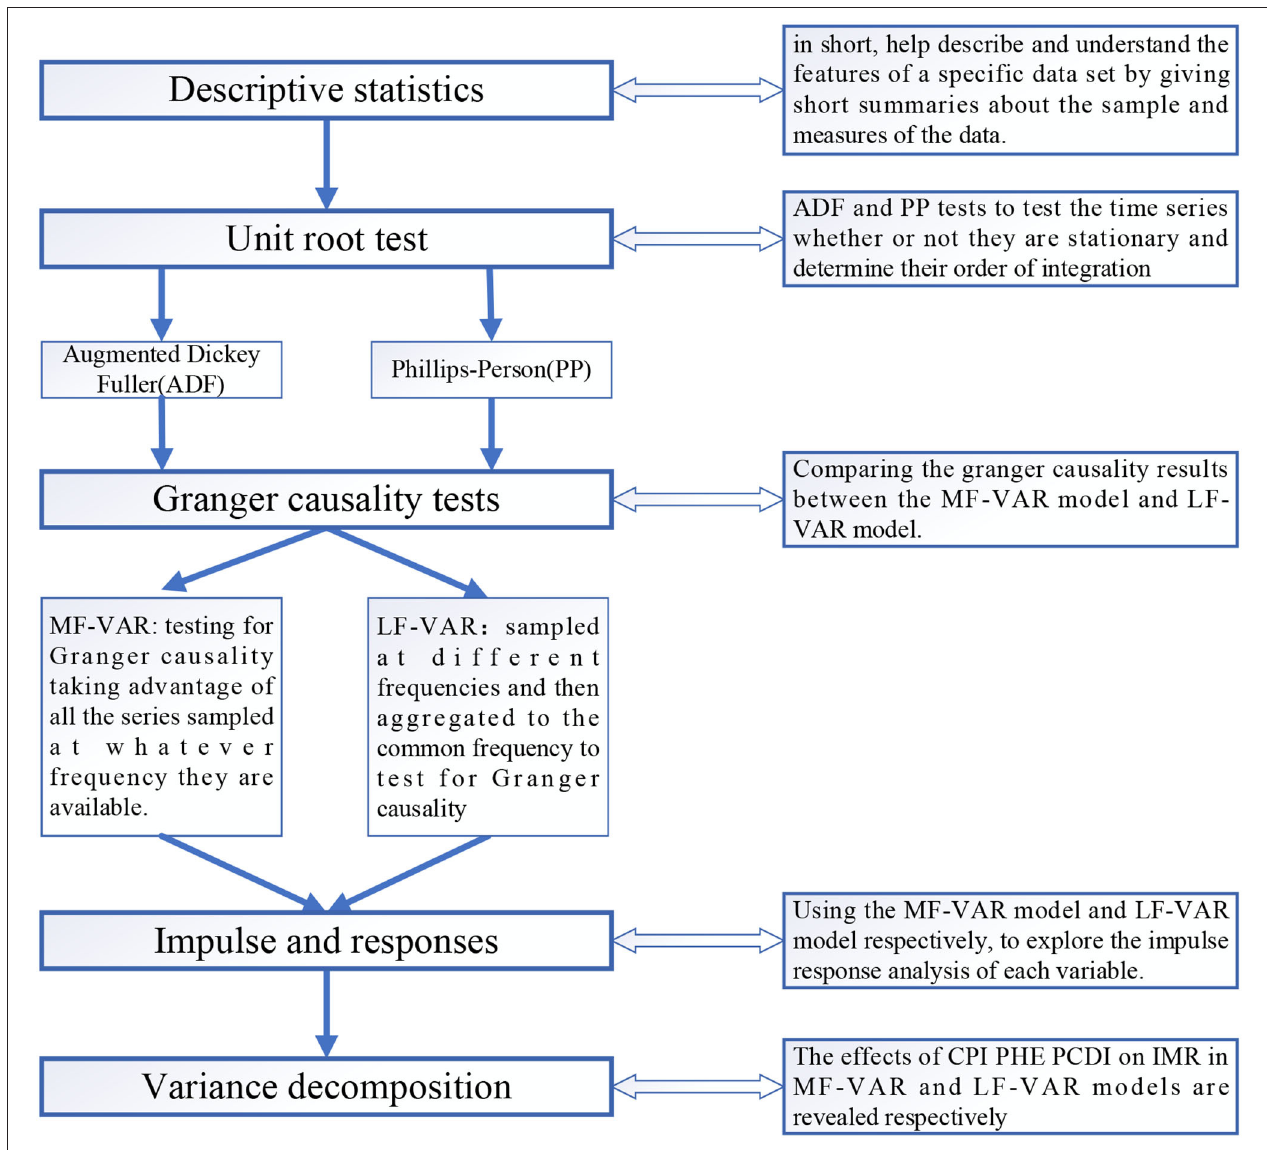
FIGURE 1 | Flowchart of the data